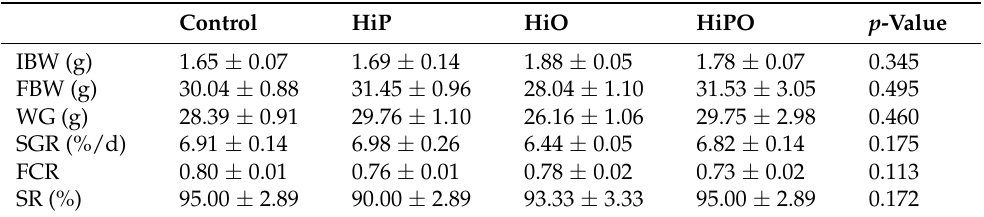
Table 4. Growth performance and feed utilization of barramundi fed partially defatted BSF larvae protein and oil as FM protein and oil replacement diets.